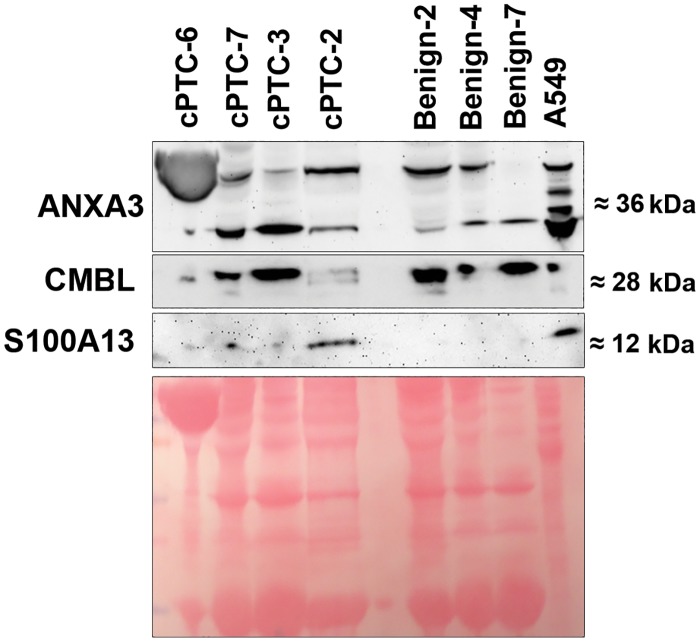
Western blot analyses of ANXA3, CMBL and S100A13 expression.Depleted cyst fluids from cPTCs and benign lesions are shown together with total protein extract from A549 cells. Protein sizes are indicated to the right in kDa. Ponceau S solution used as loading control is shown below.